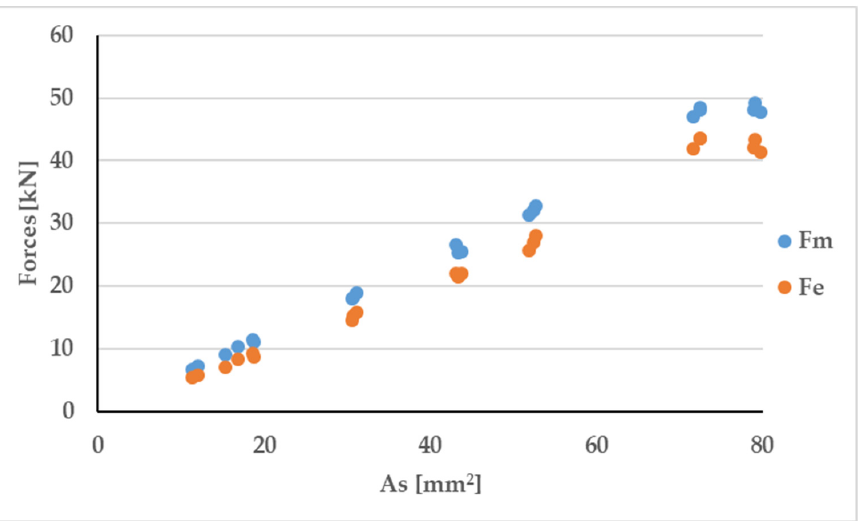
Figure 10. Dependence of the forces F e and F m on the yield strength R e and the tensile strength R m related to the area A s (standardly-treated samples).